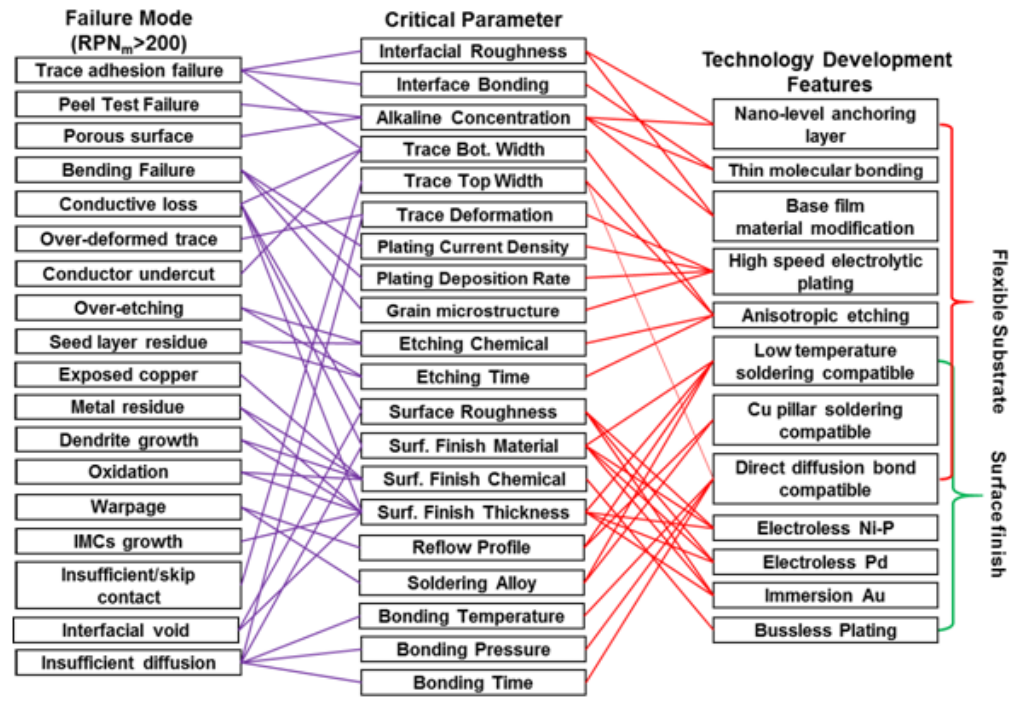
Figure 16. Correlation between high priority failure mode, critical parameter, and technology development